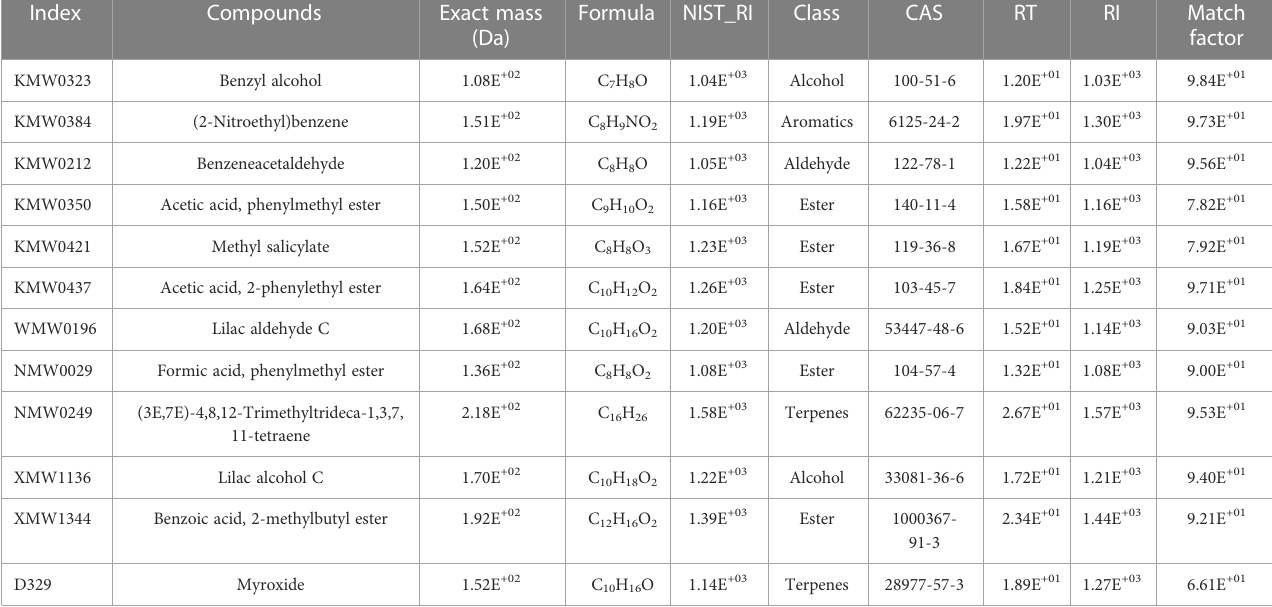
TABLE 3 Twelve different accumulative volatile organic compounds (VOCs) at different stages of Macadamia integrifolia fl ower development. Index Compounds Exact mass Formula (Da)